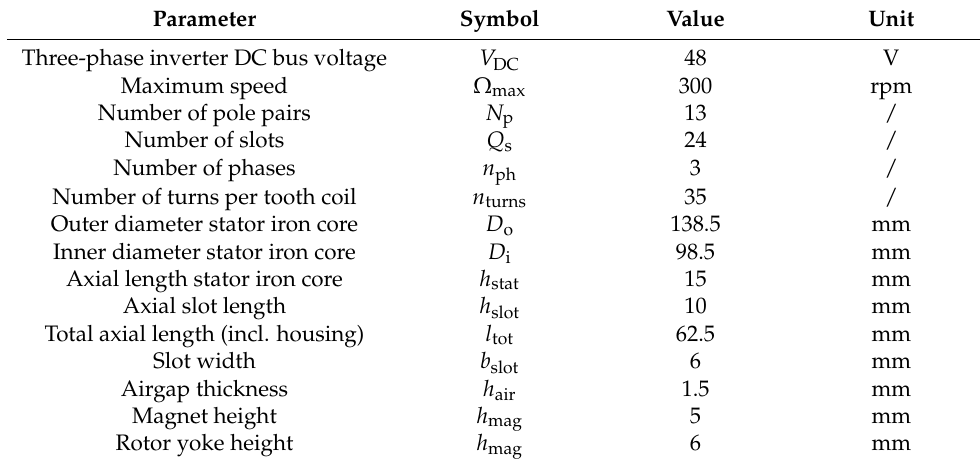
Table 1. Specifications of the test case YASA